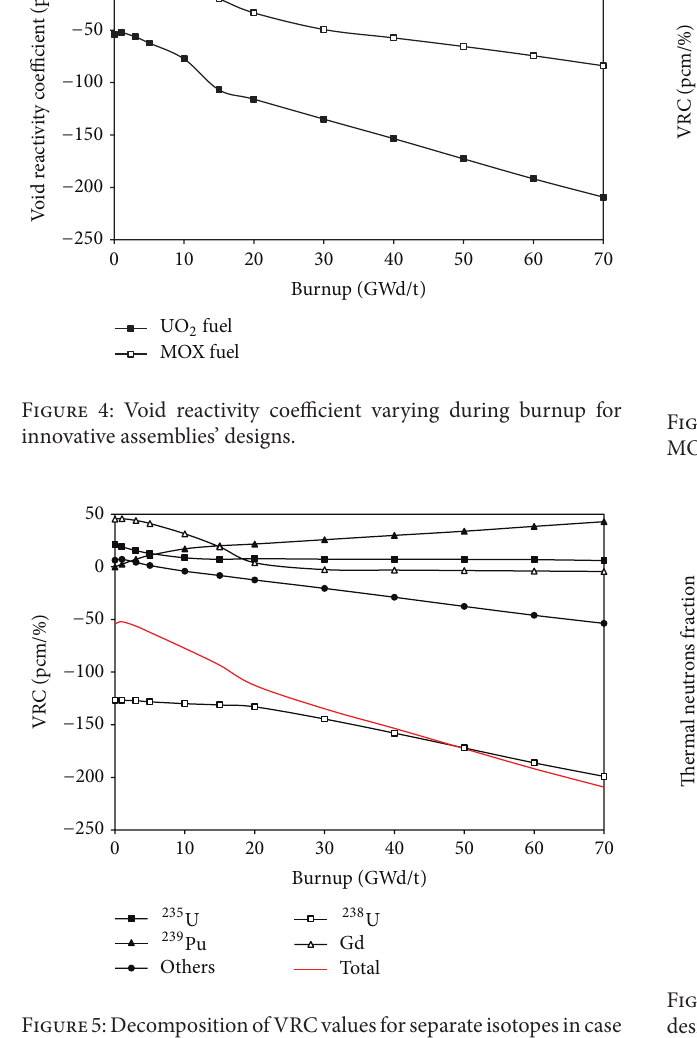
Figure5:DecompositionofVRCvaluesforseparateisotopesincase of UO 2 .